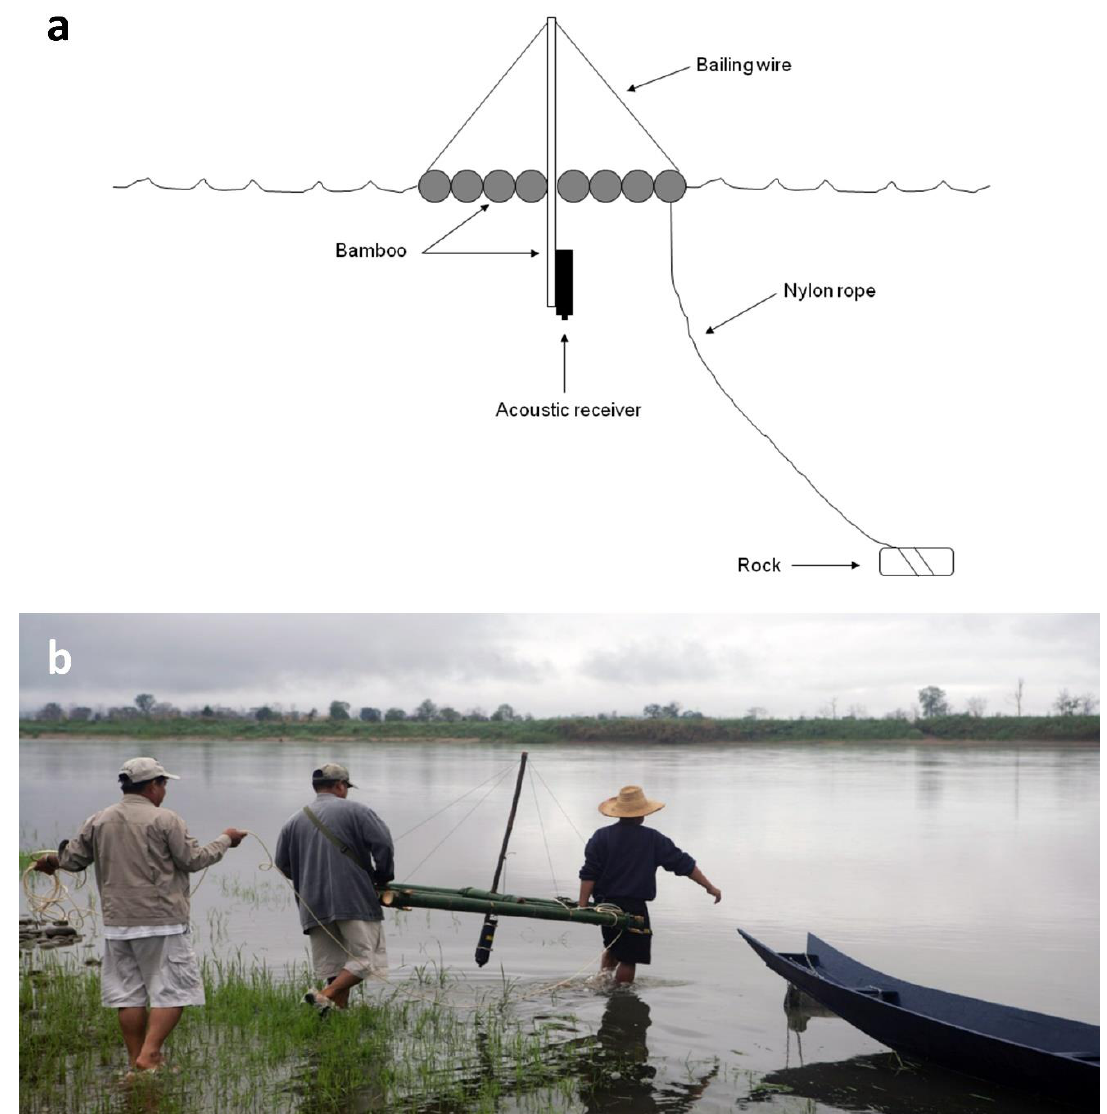
Figure 2. ( a ) Illustration of the receiver platform used to monitor acoustic-tagged catfishes in the Mekong River, Thailand – Lao PDR in 2006 – 2007. ( b ) Deployment of a receiver.